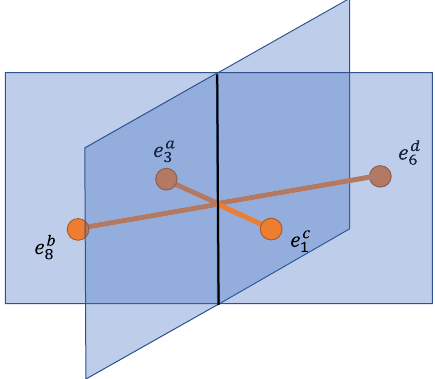
FIG. 4. Example of an electric condensation on a 1 stratum. We label the four adjacent 3 strata as { a , b , c , d } . On each 3 stra- tum, there are eight layers of 3D toric code. We label these layers { 1, 2, . . . , 8 } . Using these labeling conventions, we depict a clus- ter of electric topological charges e a 1 stratum.